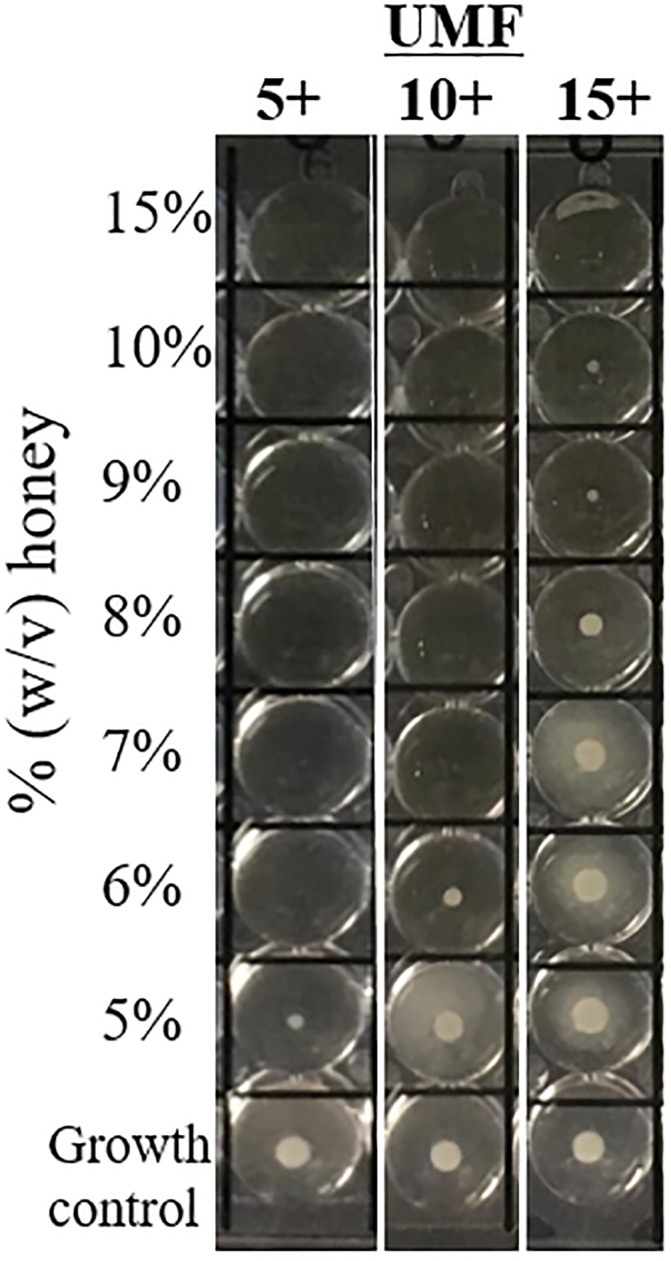
Representative broth microdilution results for an MRSA isolate tested against UMF 5+, 10+, and 15+ honeys.Images of the dilution series for each honey are cropped and shown for side-by-side comparison. Here, the MIC was 6% for UMF 5+, 7% for UMF 10+, and 15% for UMF 10+.